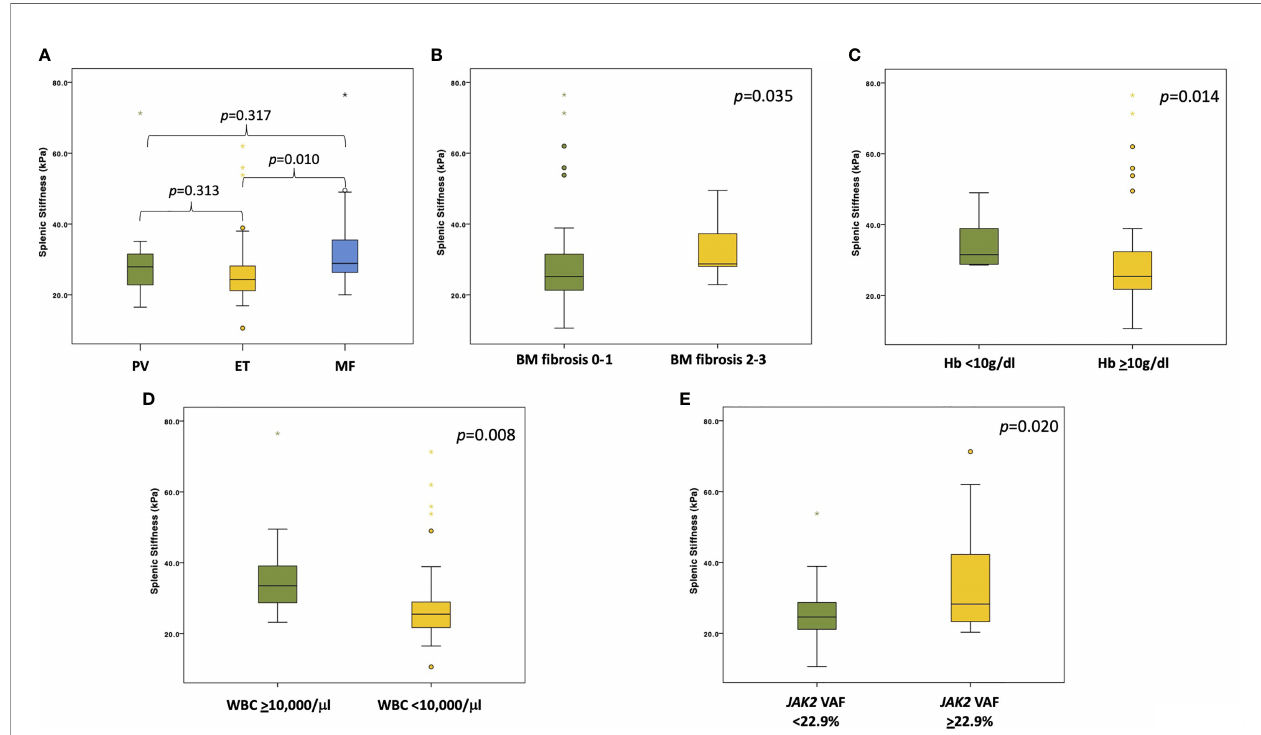
FIGURE 1 | Boxplots showing different SS values strati fi ed according to diagnosis and clinical/molecular variables. (A) The panel shows the SS values among the different MPNs (PV in green, ET in yellow, and MF in light blue). p values are reported above the boxplots. (B) The panel shows the difference in SS values between patients with grade 0-1 (in green) vs grade 2-3 (in yellow) BM fi brosis. p value is reported in the right upper corner of the panel. (C) The panel shows the difference in SS values between patients with Hb level <10 g/dl (in green) and patients with Hb level ≥ 10 g/dl (in yellow). p value is reported in the right upper corner of the panel. (D) The panel shows the difference in SS values between patients with WBC ≥ 10,000/ m l (in green) and patients with WBC <10,000/ m l (in yellow). p value is reported in the right upper corner of the panel. (E) The panel shows the difference in SS values between patients with JAK2 VAF below the median value (in green) and patients with JAK2 VAF above the median value (in yellow). p value is reported in the right upper corner of the